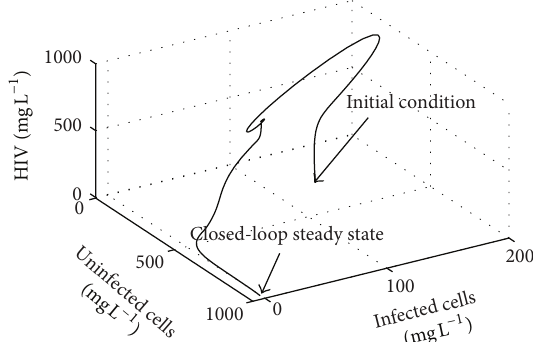
Figure 5: Closed-loop phase portrait of HIV dynamics.